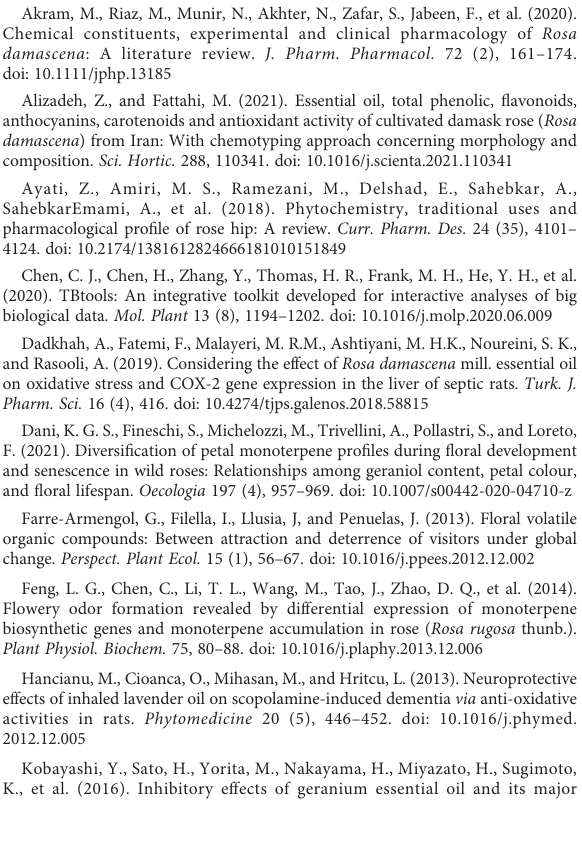
SUPPLEMENTARY FIGURE 9 S-plot of OPLS-DAbetweengroups.The x -axisisthecovariancebetween the principal component and the metabolite, and the y -axis is the correlation coef fi cient between the principal component and the metabolite. Red dots indicate VIP ≥ 1 for these metabolites, and green dots indicate VIP < 1 for these metabolites. SUPPLEMENTARY FIGURE 10 Volcano map of differential metabolites. Each point in the volcano plot represents a metabolite, the x -axis is the logarithm of the quantitative fold difference of a metabolite in two samples, and the y -axis is the VIP value. The larger the absolute value on the x -axis, the greater the fold difference of expression between two samples. The larger the y -axis value, the more strongly signi fi cant the differential expression, and the more reliable the differentially expressed metabolites obtained by screening. Green dots represent down-regulated differentially expressed metabolites, red dots represent up-regulated differentially expressed metabolites, and gray dots represent metabolites detected but not signi fi cantly different. SUPPLEMENTARY FIGURE 11 Differential metabolite KEGG pathway enrichment map. The x -axis is the Rich factor corresponding to each pathway, and the y -axis is the pathway name. The color of the point indicates the P -value – the more intensely red, the more signi fi cant the enrichment. The size of dots represents the number of enriched differential metabolites. The Rich factor is the ratio of the number of differentially expressed metabolites in the corresponding pathway to the total number of metabolites detected and annotated by the pathway. A higher value indicates a greater degree of enrichment. Pvalue is the p- value from the hypergeometric